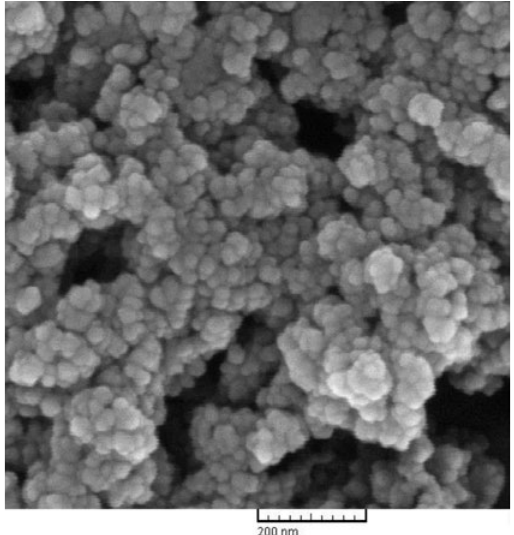
Figure 2. FE-SEM micrograph of specimen ZS-EtoH Fig. 2. FE-SEM micrograph of specimen